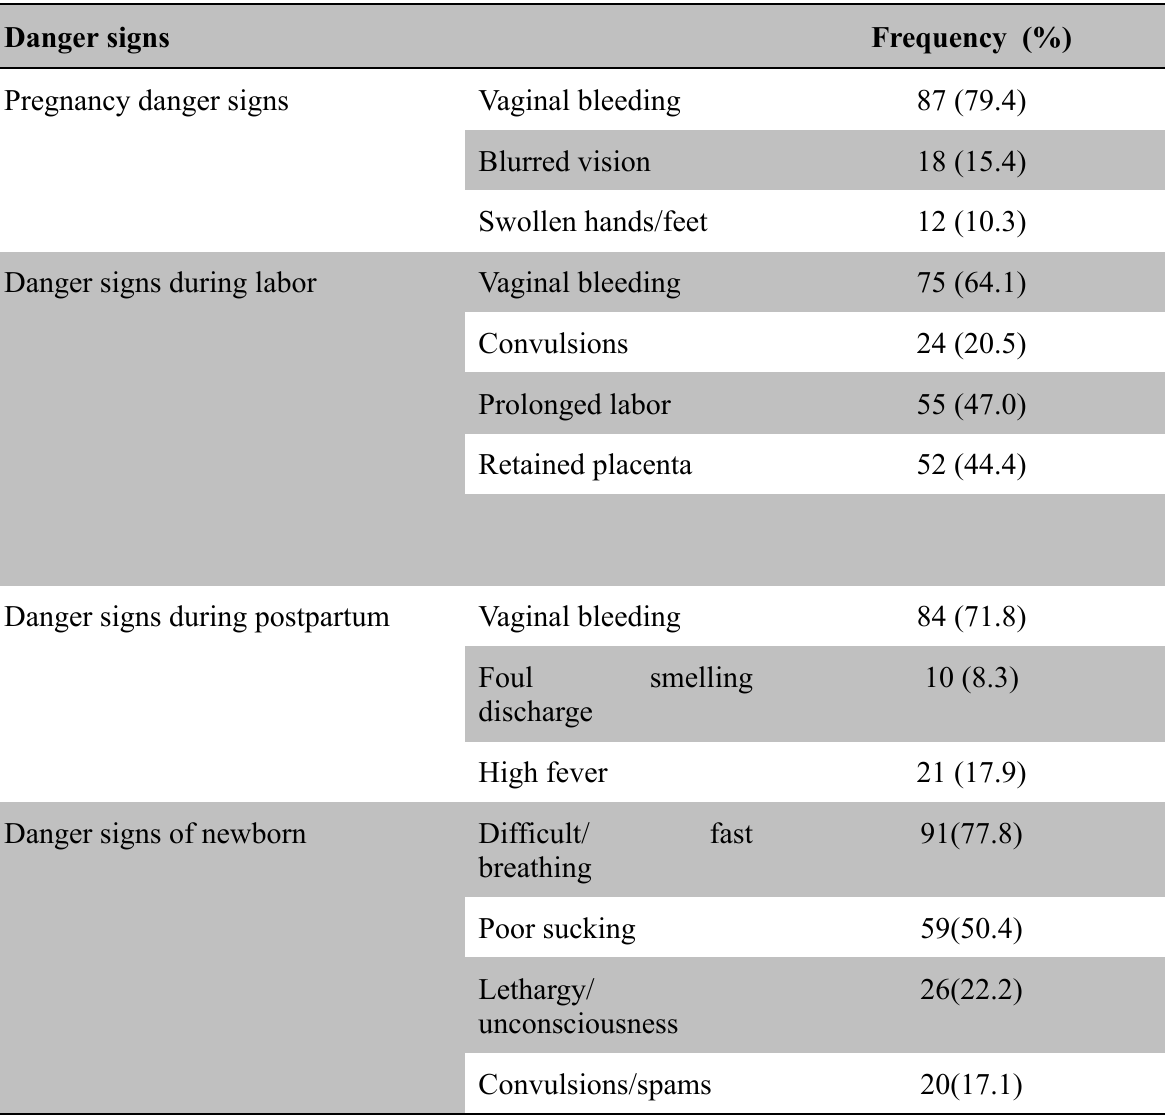
Table 3: Knowledge of danger signs during pregnancy, labor, postpartum and of newborn